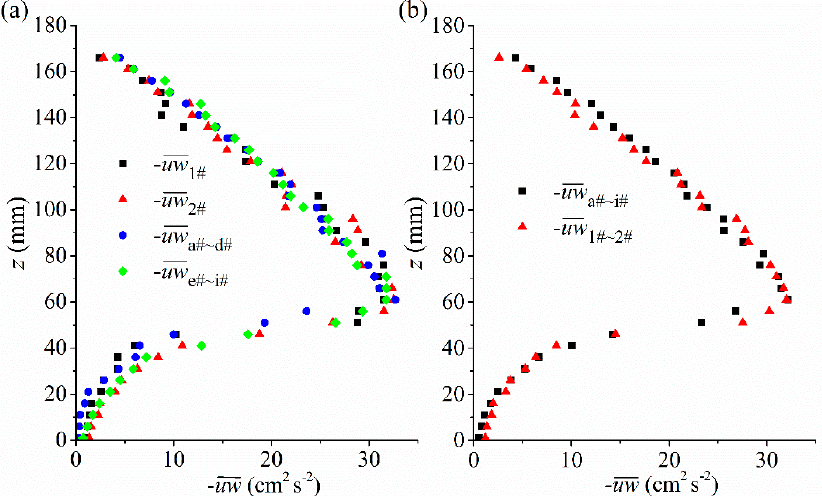
Figure 4. ( a ) Spatial variations of the Reynolds stress profiles and ( b ) the comparison between − uw 1# ∼ 2# profile and the − uw a # ∼ i # one in Case V.